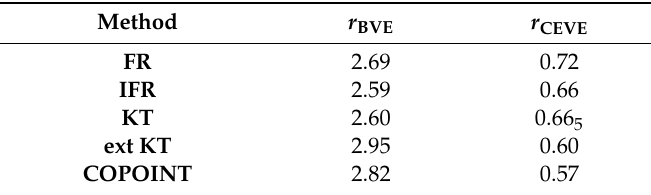
Table 2. Reactivity ratios measured by di ff erent